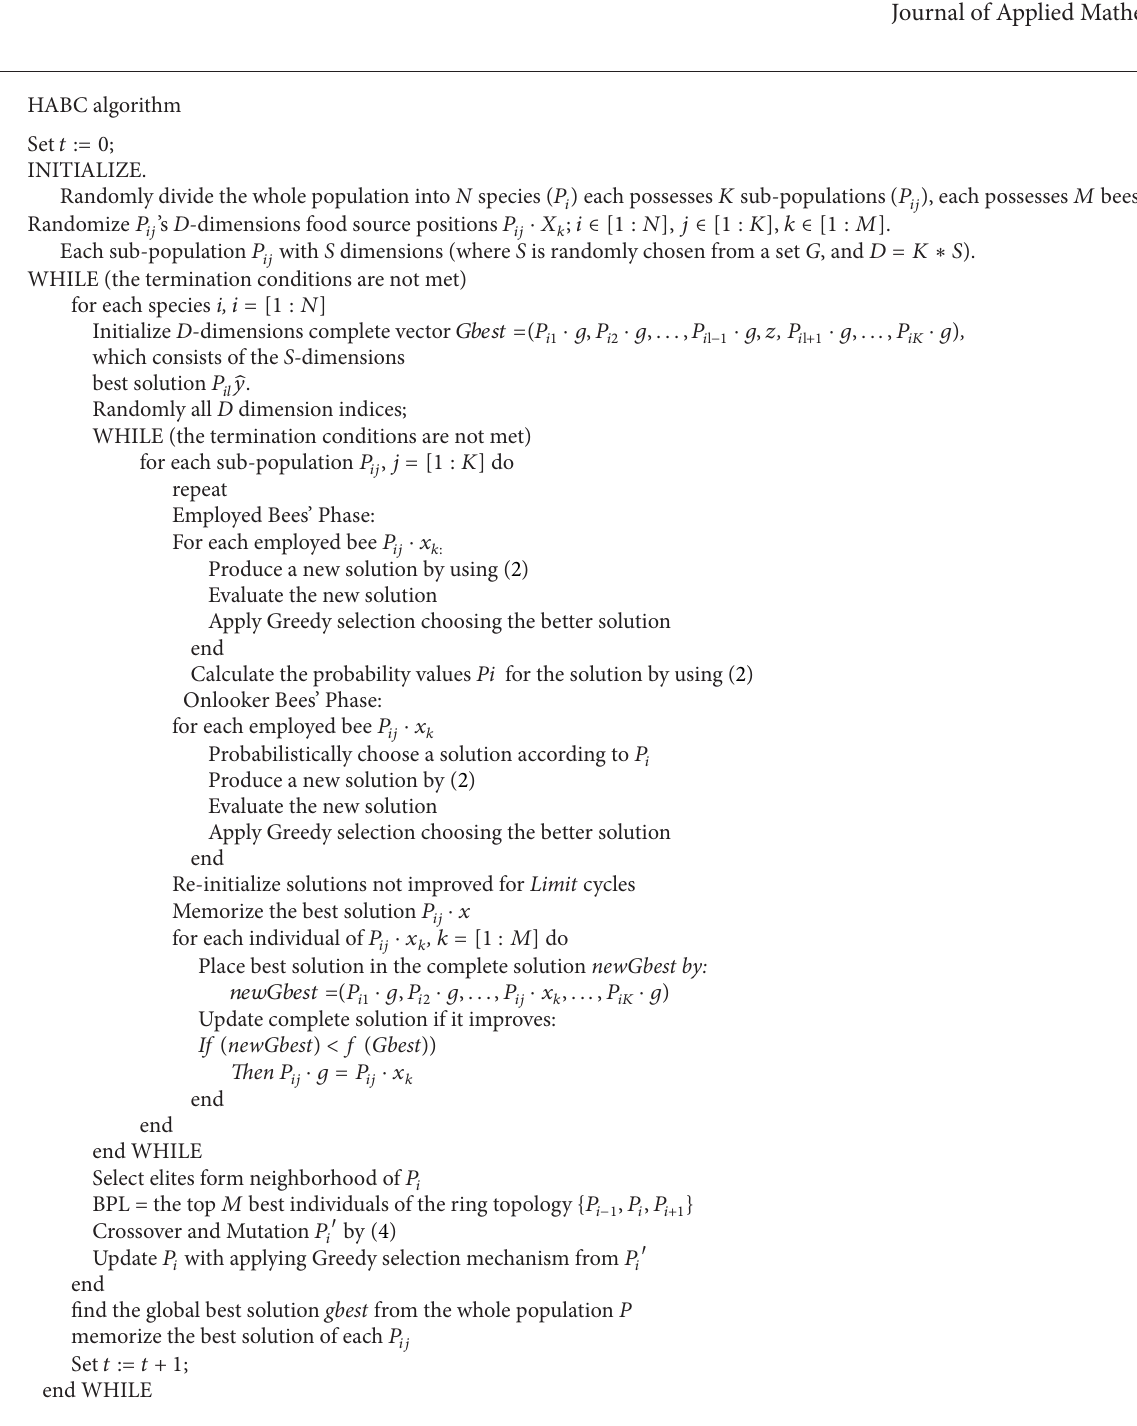
Algorithm 1: Pseudocode for the HABC